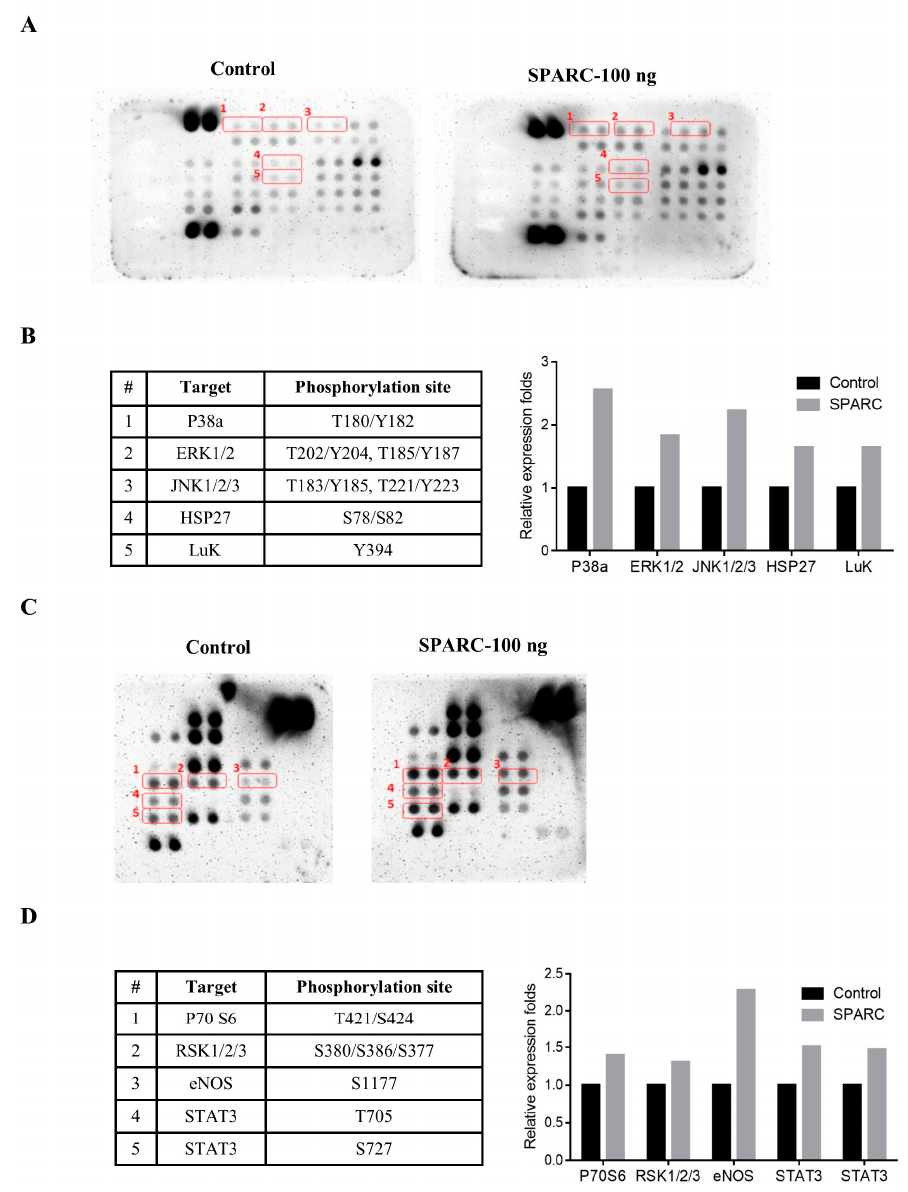
Figure 4. Investigation of SPARC treatment-activated signaling molecules by phospho-kinase array: 600 µ g of protein extract of Detroit 562 cells were subjected to a set of phospho-kinase arrays (membrane A and B) in accordance with the manufacturer’s instructions. ( A ) Phospho-kinase array, membrane A the red frame which is respectively labeled number 1 to 5 indicate different phosphorylation site. The detail information is shown in Figure 4B; ( B ) the table in the left panel indicates the specific phosphorylation site of each molecule in membrane A; the quantification result (mean density value of two duplicate spots) is shown in the right panel. Values are expressed relative to the control group; ( C ) Membrane B, the red frame 1–5 indicates specific phosphorylation site in membrane B, and ( D ) the specific phosphorylation site of each molecule in membrane B and quantification result.